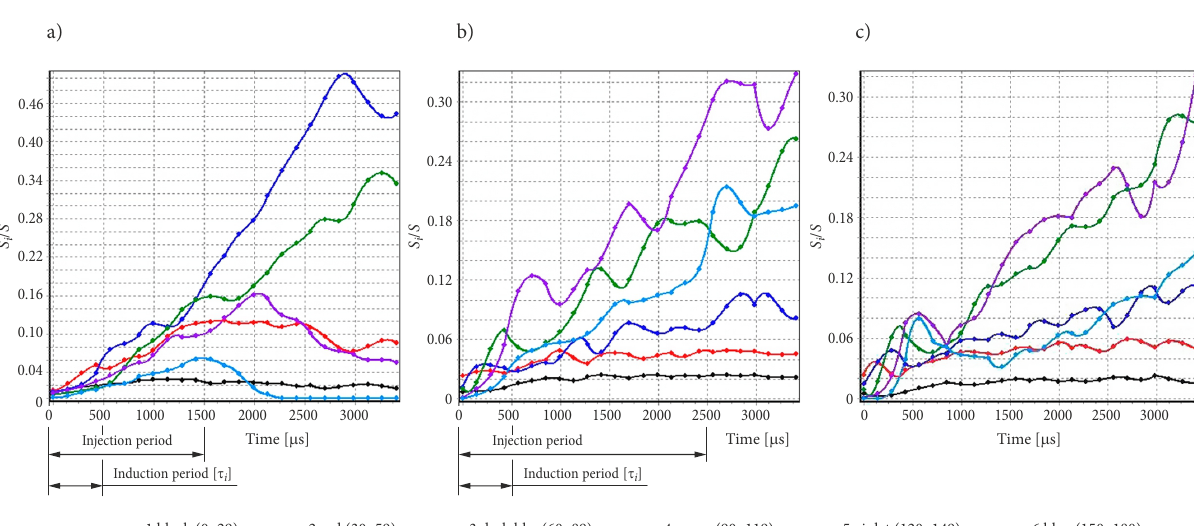
Figure 6. Fuel jet dynamics in the CDS system during injection: a – DF (26 °C); b – RO (26 °C); c – RO (65